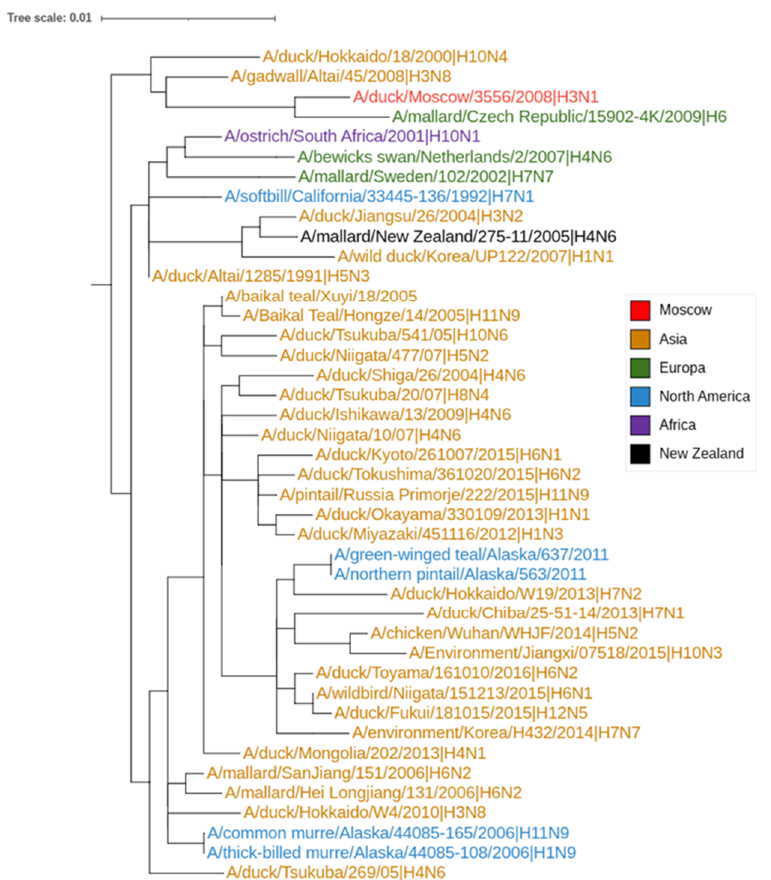
Figure 1. Fragment of the M gene phylogenetic tree. The color shows the geographical origin of the viruses.